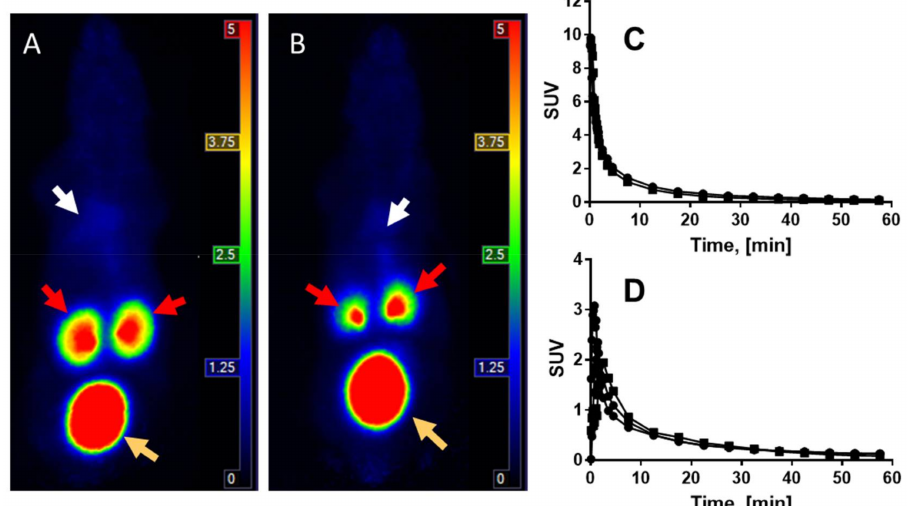
Figure 4. The representative animal PET/CT qualitative MIP images demonstrating whole body distribution of [ 68 Ga]Ga- NO2A-[Nle13]-Col in healthy mouse ( A ) and a mouse with induced fibrosis ( B ) at 60 min post injection. White, red and orange arrows point respectively at the liver, kidneys, and urinary bladder. ( C ) Blood clearance from the heart of [ 68 Ga]Ga-NO2A-[Nle13]-Col administered intravenously to healthy mice (R 2 = 0.9533 ( • )) and diseased mice (R 2 = 0.994 ( (cid:4) )). ( D ) Washout from the liver of healthy ( • ) and diseased ( (cid:4) )